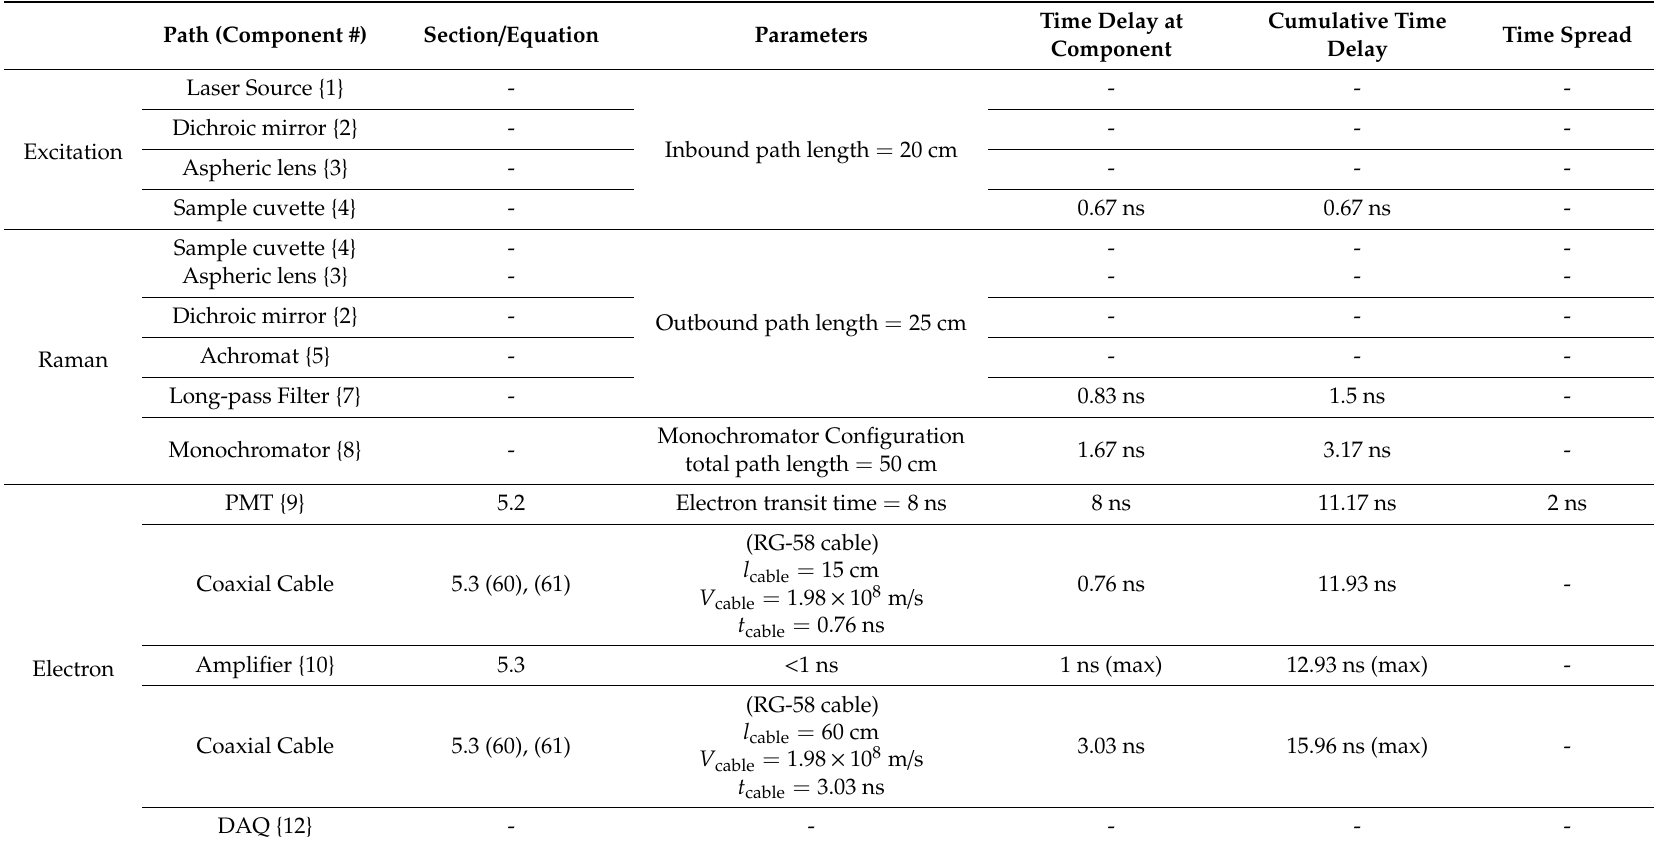
Table 9. Purdue CE Spectroscopy Lab 532 nm open-path TRRS example time